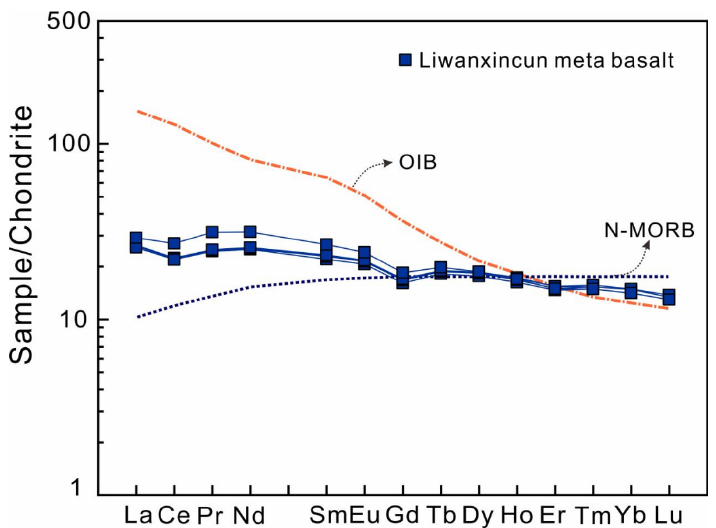
Figure 9. Chondrite-normalized rare element (REE) diagram of the Liwanxincun metabasalt. Chondrite data are from Sun and McDonough (1989) [26].